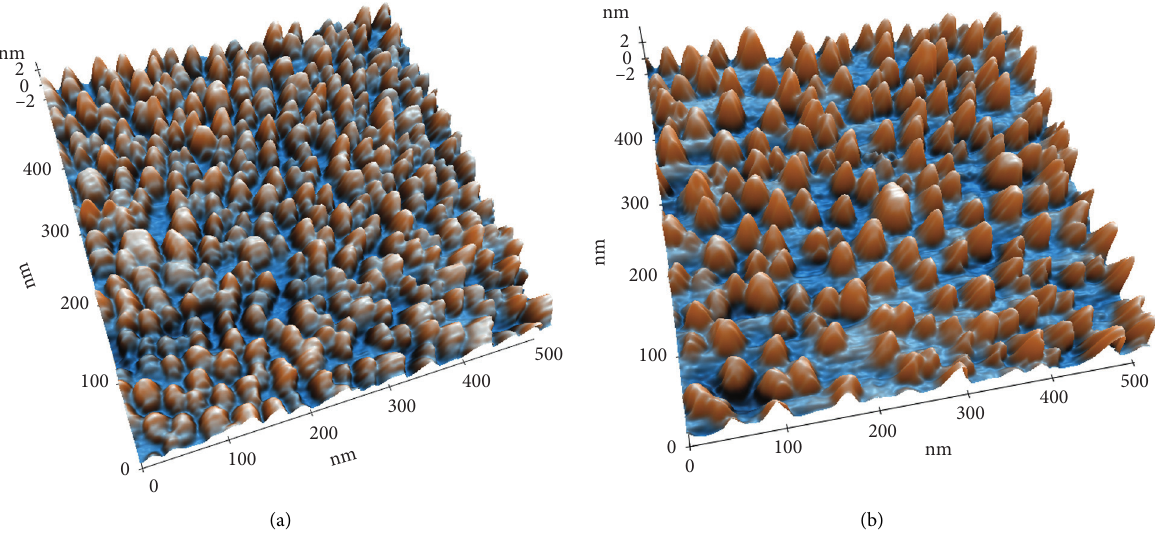
Figure 1: Atomic force micrographs of (a) active Ga(As)Sb QDs on GaAs and (b) nonactive QD-like objects grown from Ga(As)Sb on Al 0.5 Ga 0.5 As. Be aware of the different scale in the height dimension as opposed to both lateral dimensions along the growth front.